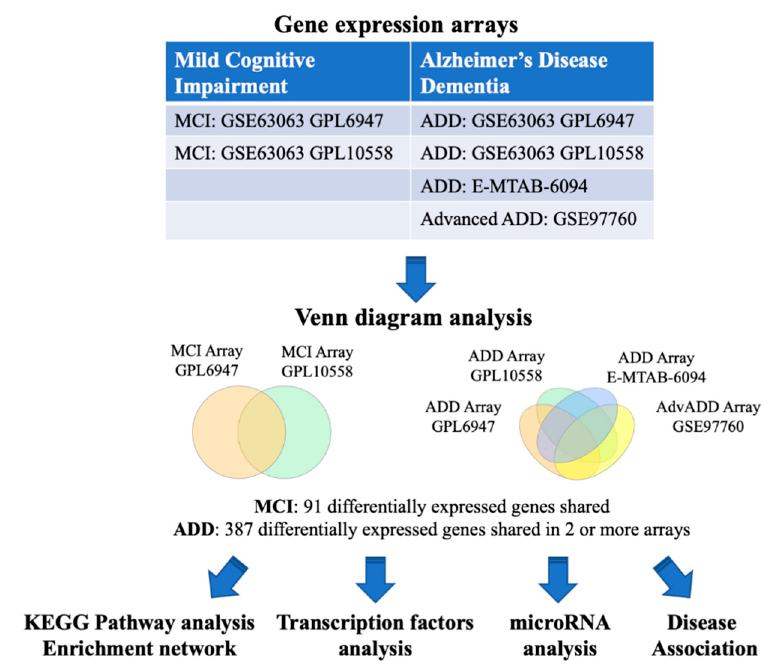
Figure 1. Flowchart of the study. The BaseSpace Correlation Engine (BSCE) was searched and blood gene expression studies with data from mild cognitive impairment (MCI) and Alzheimer’s disease dementia (ADD) were included in this study. Venn diagram analysis was used to identify shared dysregulated genes. The MCI and ADD dysregulated genes were analyzed for shared functional pathways, transcription factors, and miRNAs regulation as well as disease associations. The arrows represent the flow of the steps in the study. Table 1. Gene expression datasets used in this study.